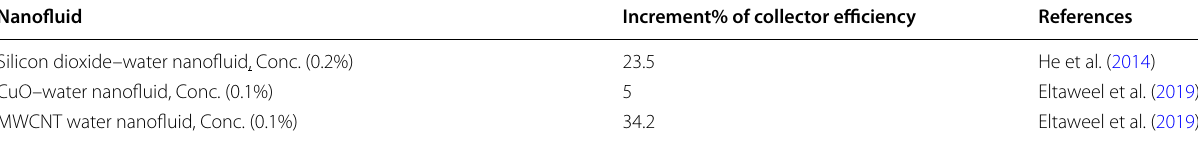
Table 2 Effect of several types of nanofluids on increasing the thermal efficiency of FPC (Faizal et al. 2015) Nanofluid